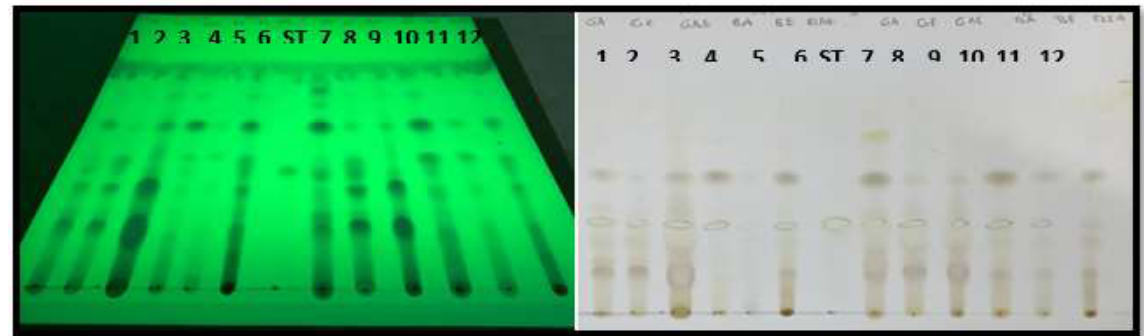
Table 4. The R f values of epicatechin in all ethyl acetate fractions with epicatechin standard in best three mobile